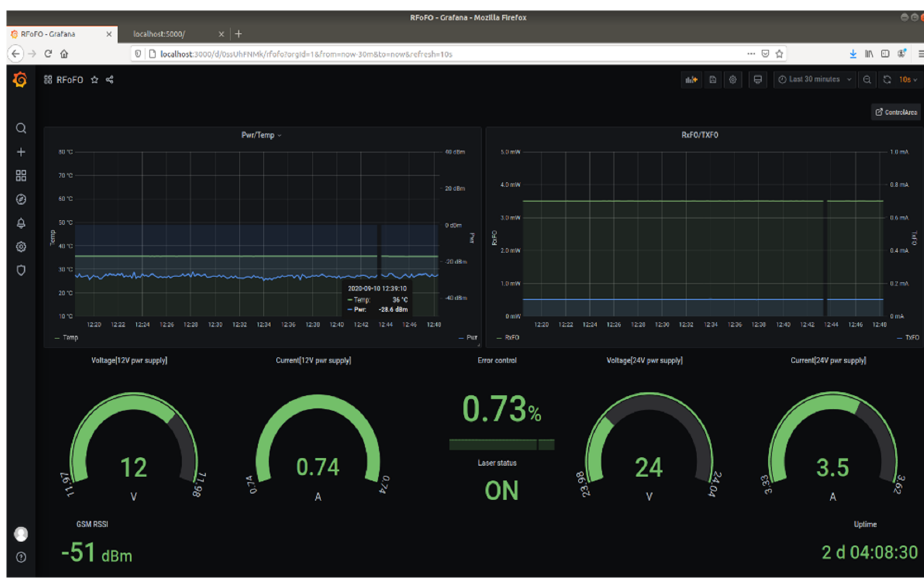
Figure 4. Monitoring dashboard.